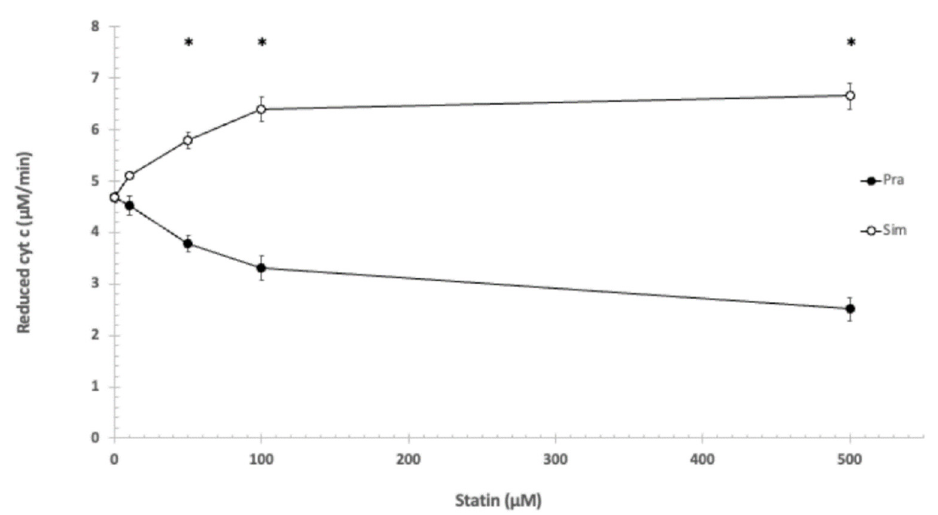
Figure 1. The effect of pravastatin and simvastatin on the reduction of cytochrome c. 1 mM EDTA, 100 mM Tris/HCl (pH = 8.0), T = 25 °C. * shows significant difference.